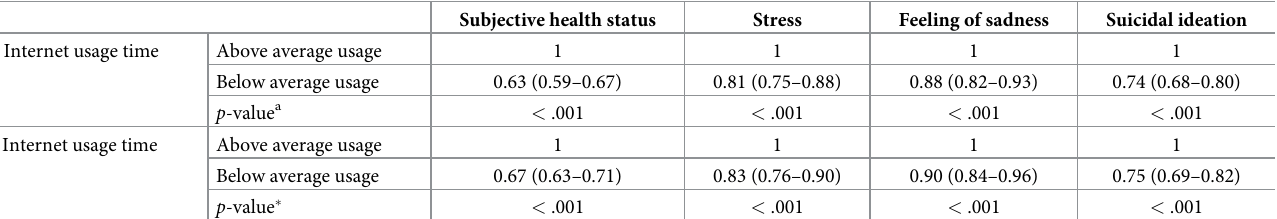
Table 2. Logistic regression for daily Internet usage on mental